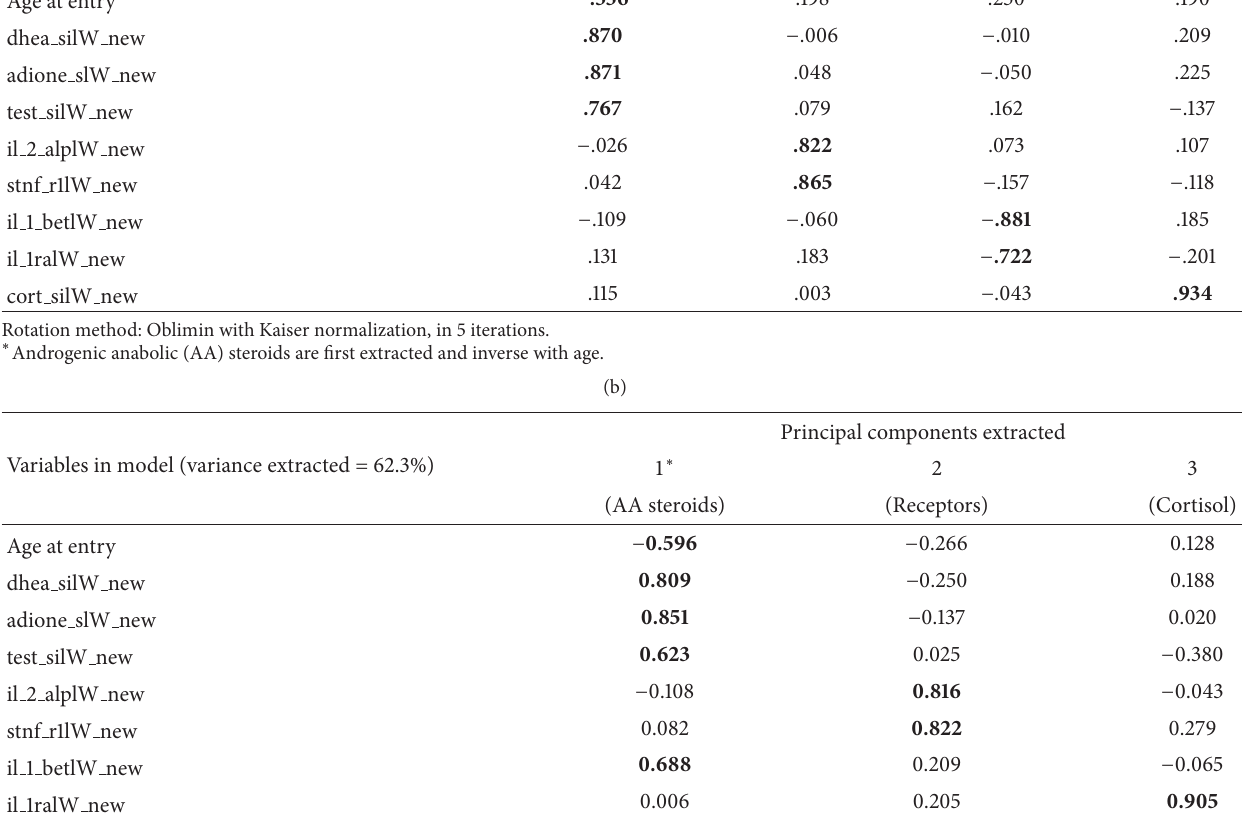
Variables in model (variance extracted =